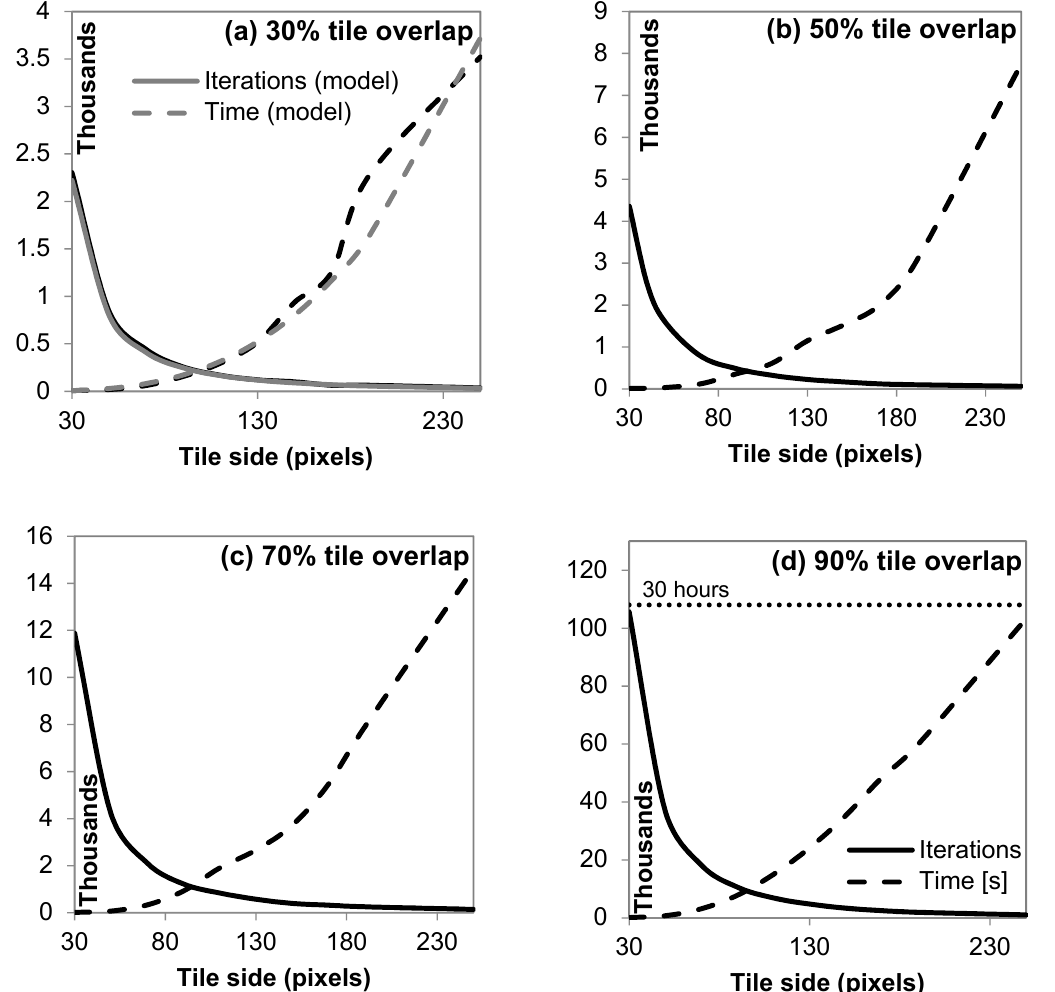
Figure 5. Resulting iterations and computational processing unit (CPU) time [s] from the cascading of rectangular tiles with side 𝑝 ranging from 30 to 250 pixels and overlap of 30 to 90%.